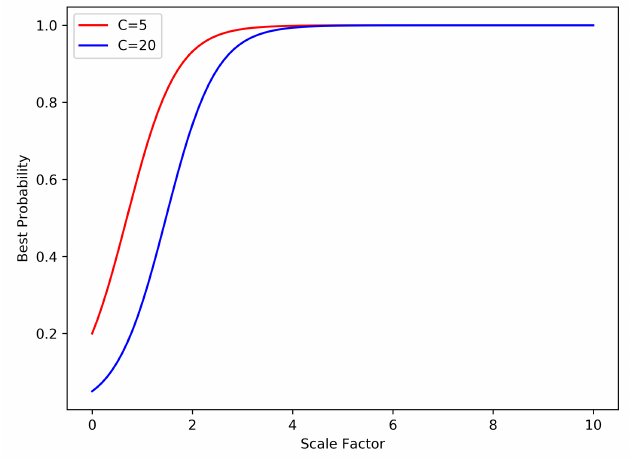
Figure 4. Best probabilities of SoftMax classifier using cosine